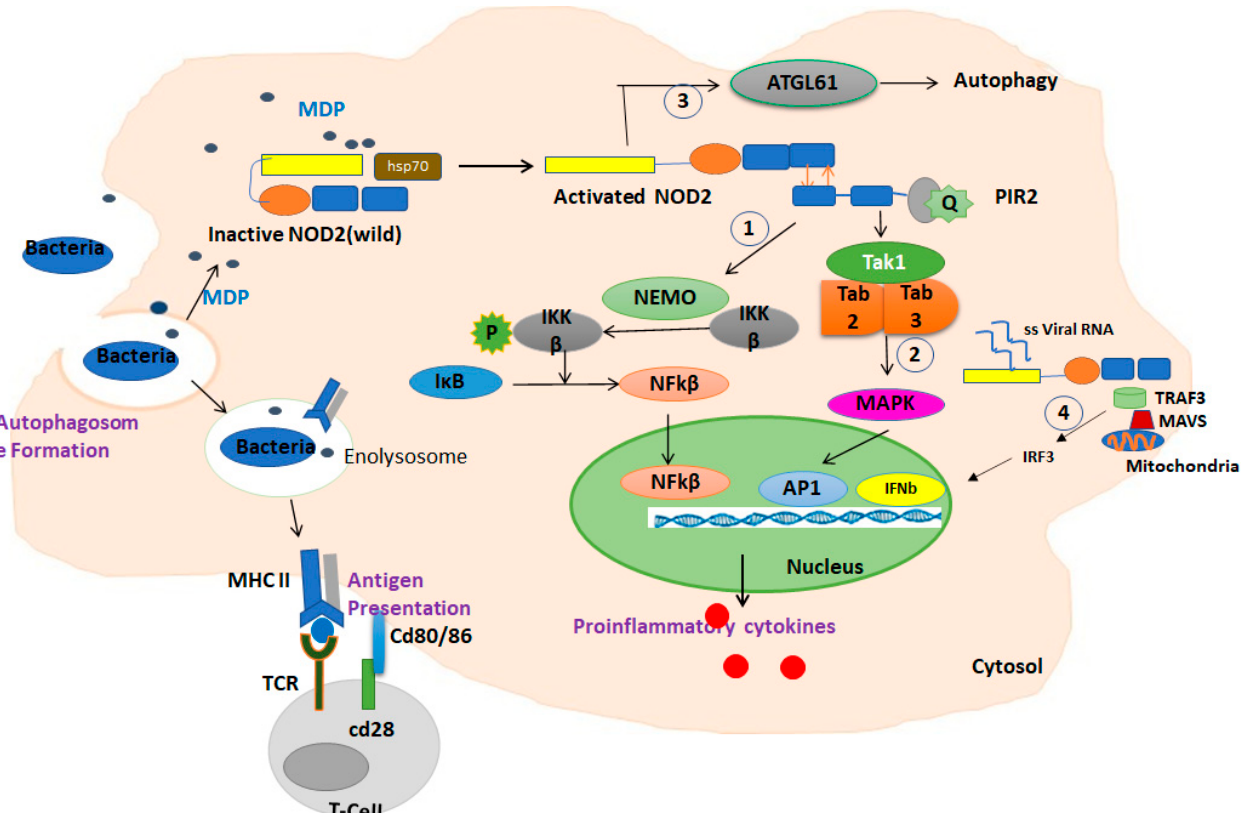
Figure 2. Summary of the function of NOD2 in response to MDP in macrophages. In the absence of a ligand, NOD2 is in an inactive autoinhibited form by folding the LRR domain onto NBD and CARD domains stabilized by chaperone proteins such as HSP70. Upon ligand binding and receptor activation, the C-terminal LRR domain of NOD2 undergoes a conformational change and exposes the CARD domain to interaction and oligomerization with the CARD domain in the adaptor molecule RIP2 through a homophilic CARD–CARD interaction. Upon oligomerization, PIR2 activates and promotes the ubiquitination of lysine 209 located at the kinase domain. (1) This ubiquitination promotes the recruitment of TAK1 and NEMO (the NF-kB essential modulators). The activation of TAK1 and NEMO promotes the phosphorylation of IKK β , which is a key kinase in the NF- κ B signaling pathway. Phosphorylated IKK β degrades I κ B and subsequently activates NF- κ B family transcription factors. (2) In addition, this path also activates the MAPKs and AP1 pathways. The NF- κ B and MAPK pathways are responsible for triggering the expression of inflammatory cytokines. (3) Activated NOD2 also may trigger an autophagic pathway by recruiting ATG16L1. (4) The interaction of NOD2/TRAF3 with mitochondrial antiviral signaling protein (MAVS) upon sensing viral ssRNA induces the activation of IRF3, triggering the expression of IFN- β